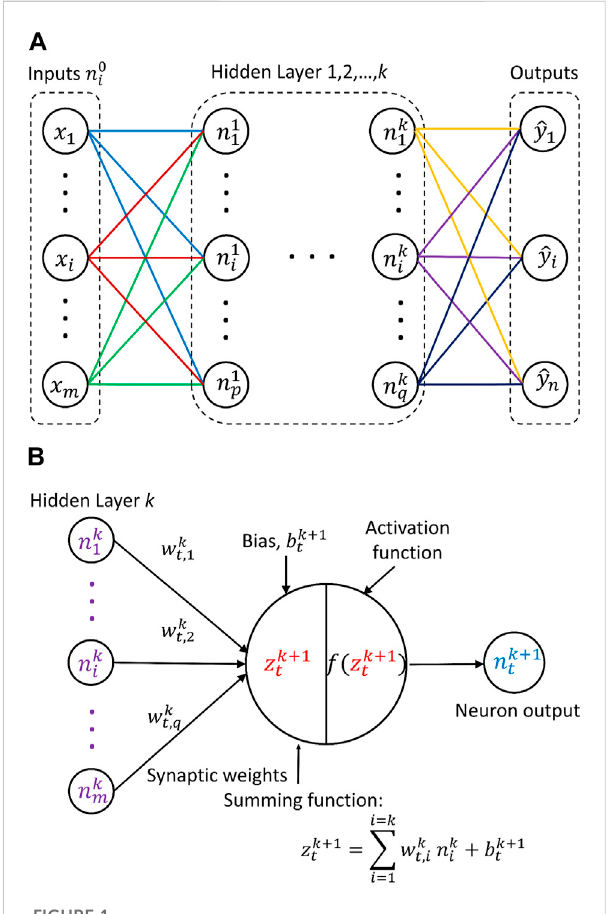
ConstructionofanANN: (A) layerednetwork; (B) arti fi cialneuron.